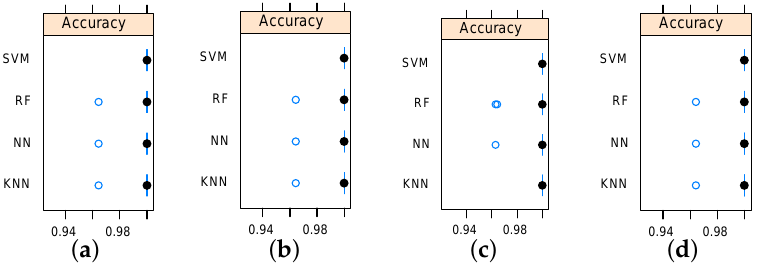
Figure 8. Box-and-whisker diagrams indicating the accuracy variation for the implemented classifiers using two-dimensional data sets. ( a ) using IG based data set; ( b ) using GR based data set; ( c ) using relief based data set; ( d ) using chi-Squared based data set.